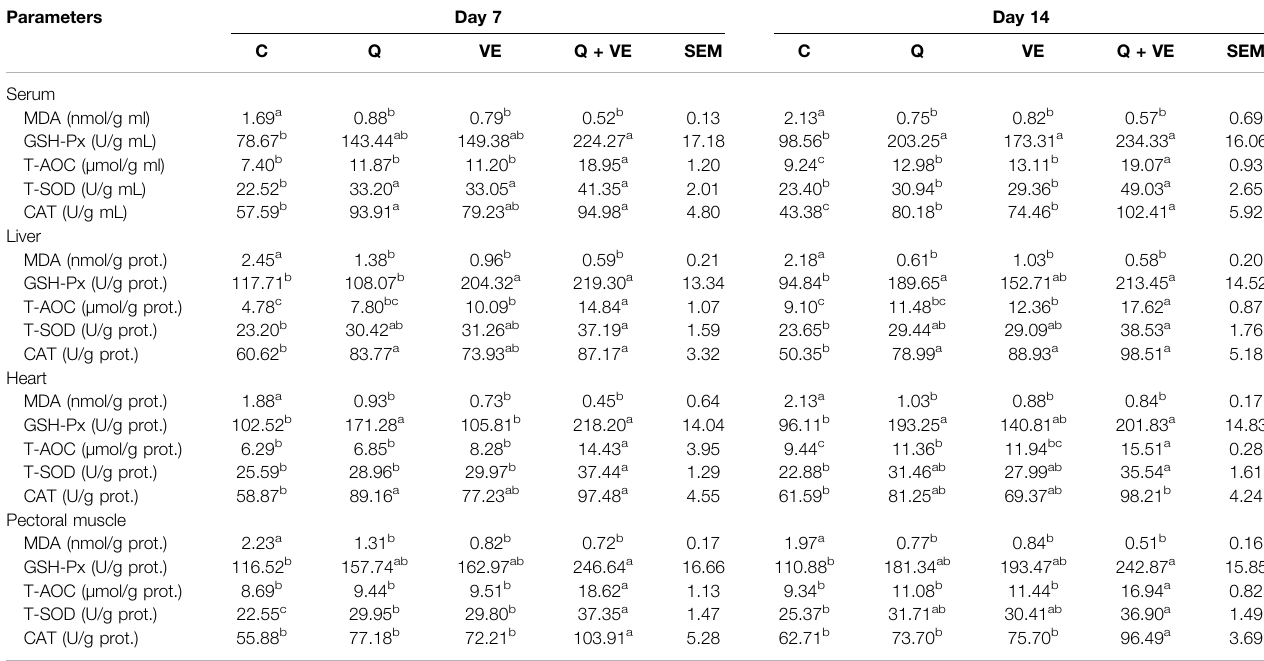
TABLE 8 | Dietary effects of Q, VE, and Q + VE on the antioxidant status of the 14-day-old chicks. Parameters